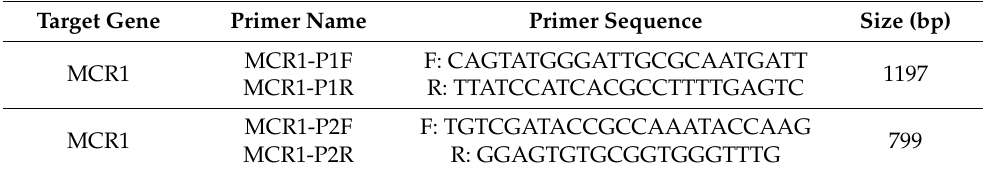
Table 1. Primer sequence for mcr-1 gene detection in Salmonella